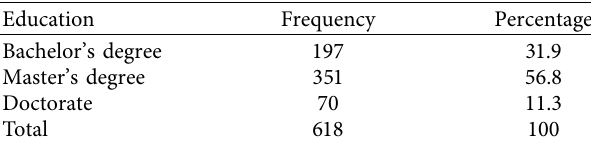
Table 2: Frequency distribution by education level.